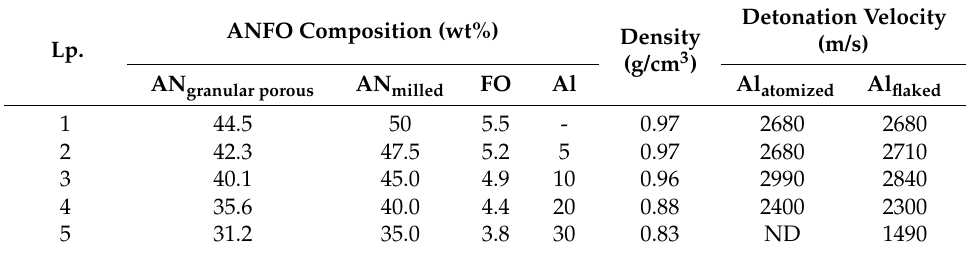
Table 5. Detonation velocity of ANFO with the addition of aluminium [29].